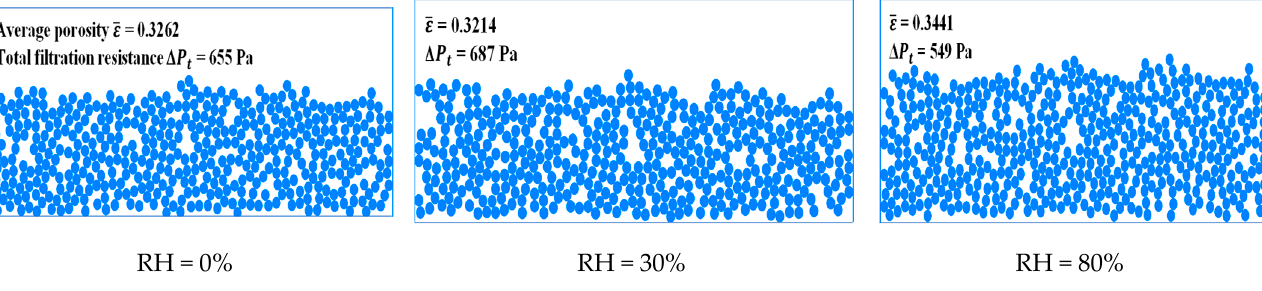
Figure 8. Three particle deposition patterns with different humidities (layers 7, 8 and 9).